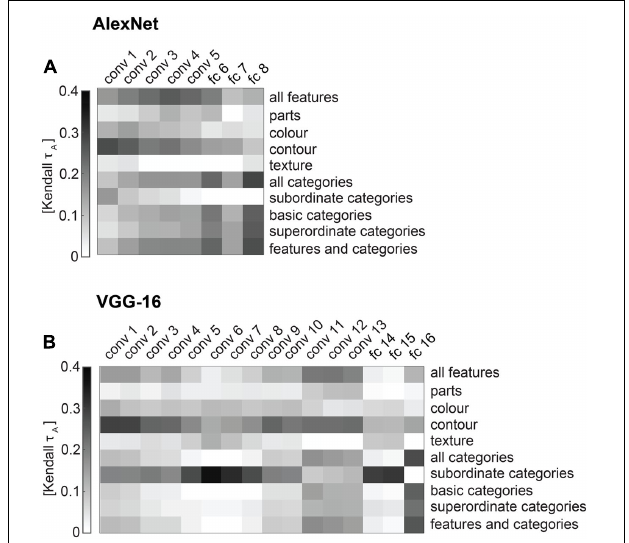
FIGURE 11 | Correlations between DNN and conceptual model predictions of the similarity judgments. (A) The matrix shows pairwise correlations of AlexNet layer RDMs and conceptual models (Kendal tau a). (B) The matrix shows pairwise correlations of VGG-16 layer RDMs and conceptual models (Kendal tau